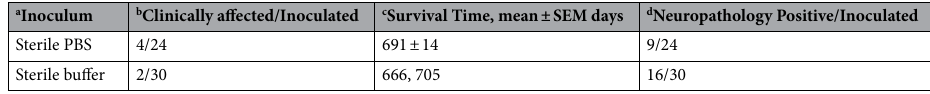
Table 1. Incidence of clinical signs and neuropathological changes in Tg20 mice challenged with D-PBS or buffer. a Groups of mice were inoculated intracerebrally with either D-PBS as a standard inoculation control or with sterile buffer comprising 20 mM Tris + 20 mM sodium acetate + 200 mM NaCl pH 4.0. Mice were then observed daily over their lifespan and culled if showing signs of clinical prion disease, distress caused by inter-current illness, or senescence or at termination of the experiment. b Clinical disease was defined by the criteria described in Methods. c Survival times are reported for mice with clinical signs consistent with prion disease in days post inoculation; where n ≥ 3 the mean ± SEM is reported, otherwise individual survival times are given. d Brains from all 54 mice reported in the Table were examined and classified by neuropathological examination and immunohistochemistry. Positive neuropathology comprises spongiform change, either alone, or in combination with the presence of abnormal PrP